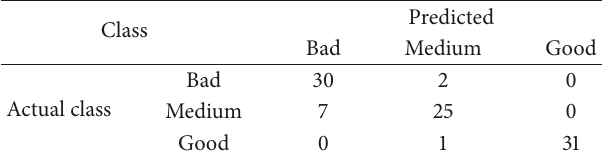
Table 4: Confusion matrix of our CNN model for flower